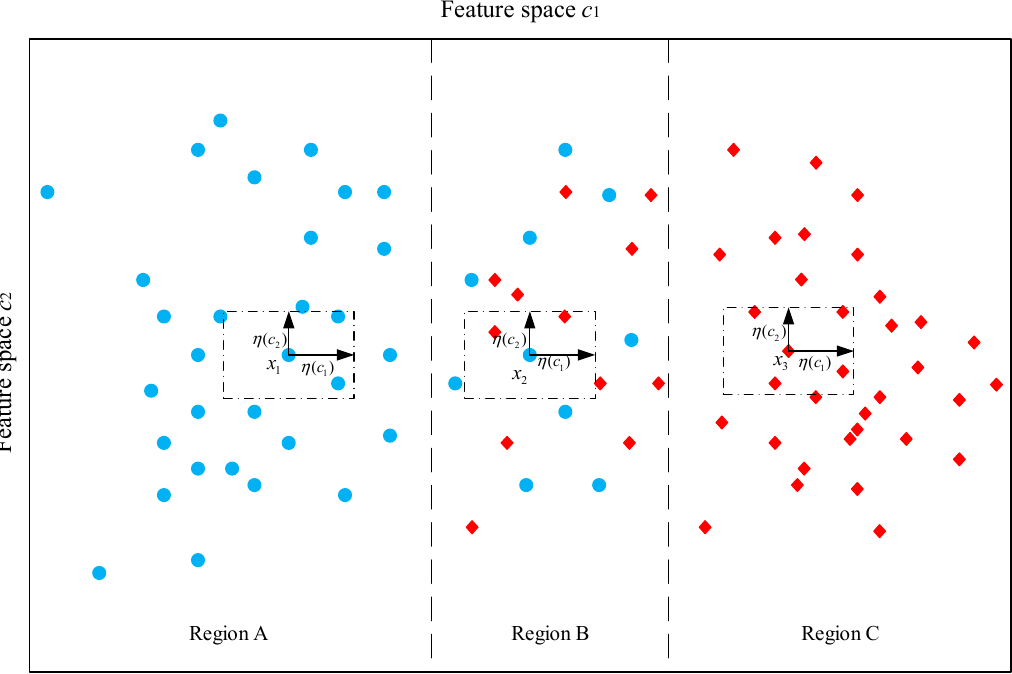
Figure 3. An illustration of positive region and boundary region.